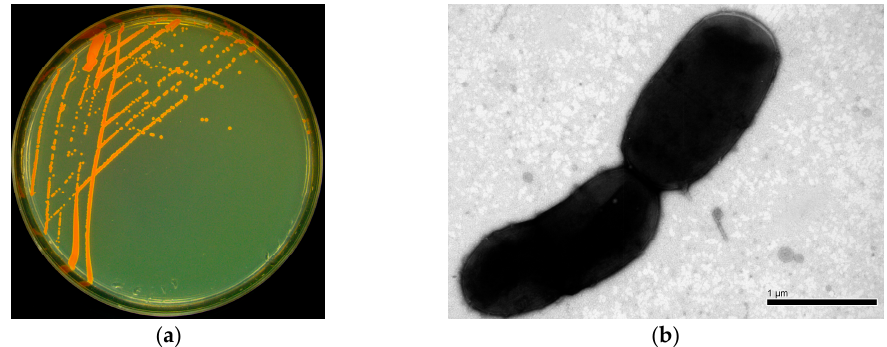
Figure 1. ( a ) The colonial morphology of strain YC-YT1 on a Luria-Bertani plate; ( b ) Morphological characteristics of strain YC-YT1 by scanning electron microscope (Hitachi-SU8010).